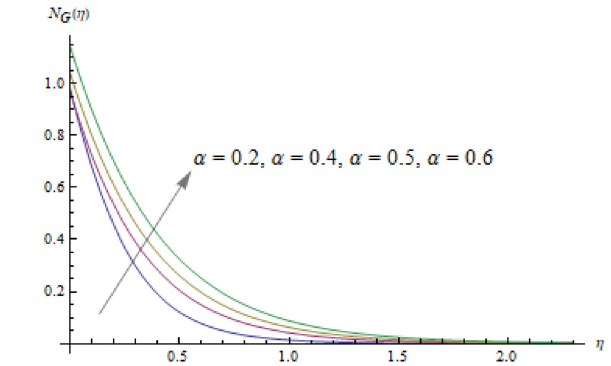
Fig. 32 Impact of α on N G (η)